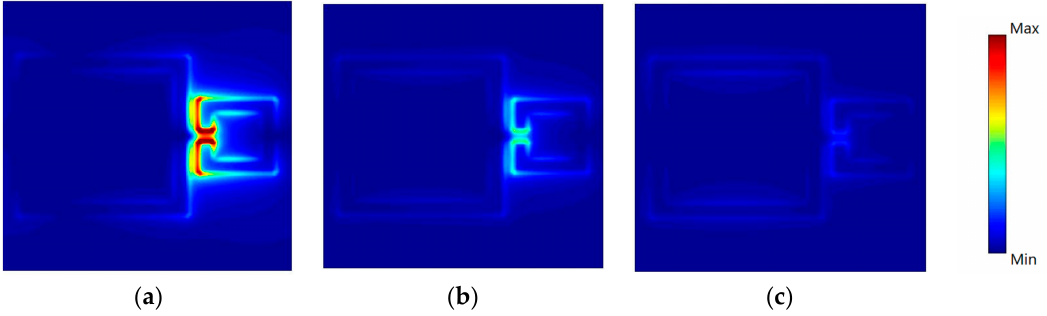
Figure 5. The electric field distributions of the plasmon-induced transparency (PIT) metamaterials at 0.58 THz for the cases ( a ) without graphene; ( b ) E F = 0.1 eV; and ( c ) E F = 0.4 E .